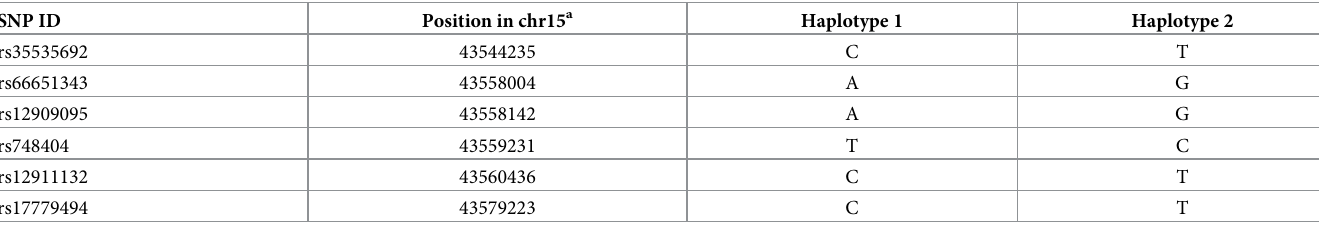
Table 1. SNPs in the core